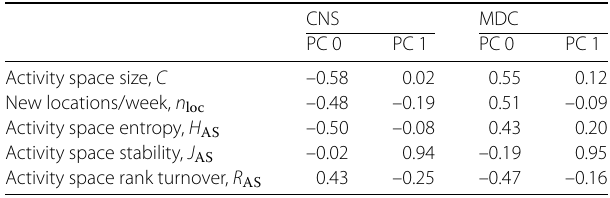
Table 11 Principal components (only spatial data). The weight of each metric in the first two principal components, for both